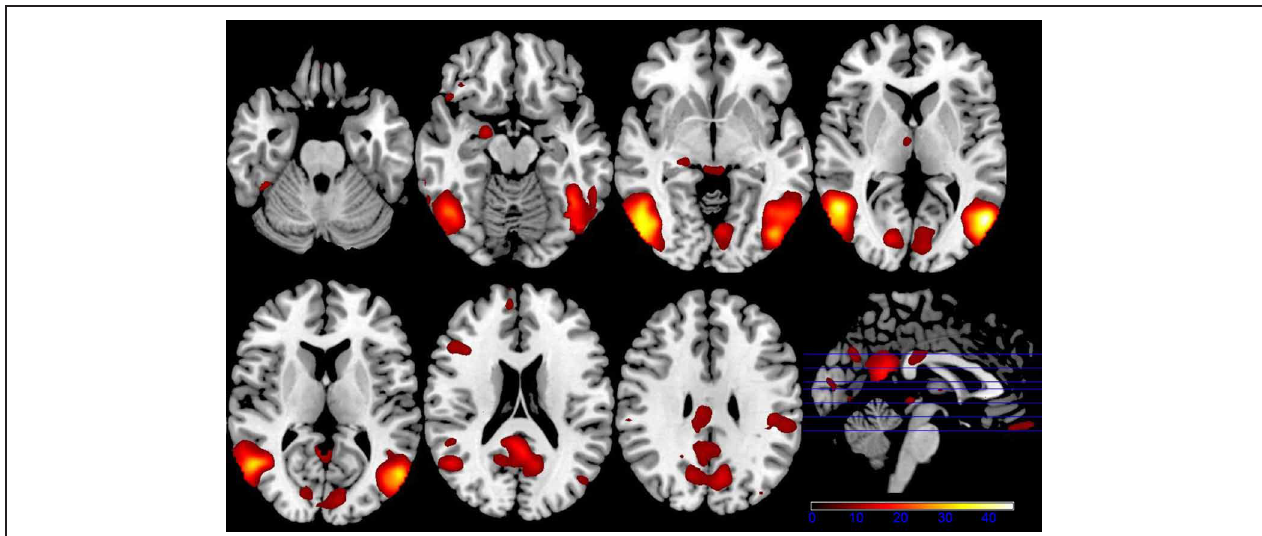
FIGURE 1 | Axial slices depicting the main effect of emotional categories resulting from a 2 × 3 ANCOVA using the individual glucose level difference as a covariate ( p < 0 . 001 uncorrected for whole-brain volume analysis; for a more detailed description of activated brain regions, please see Table 1).